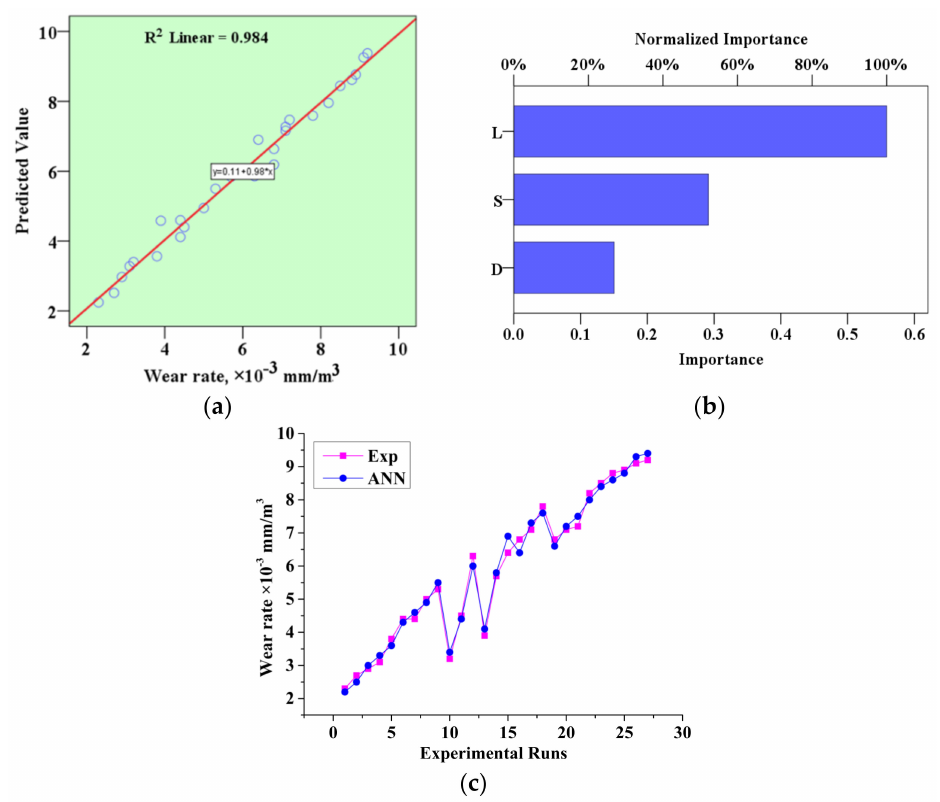
Figure 15. ANN analysis for sample A0: ( a ) experimental vs. predicted values; ( b ) normalized factor importance; and ( c ) error